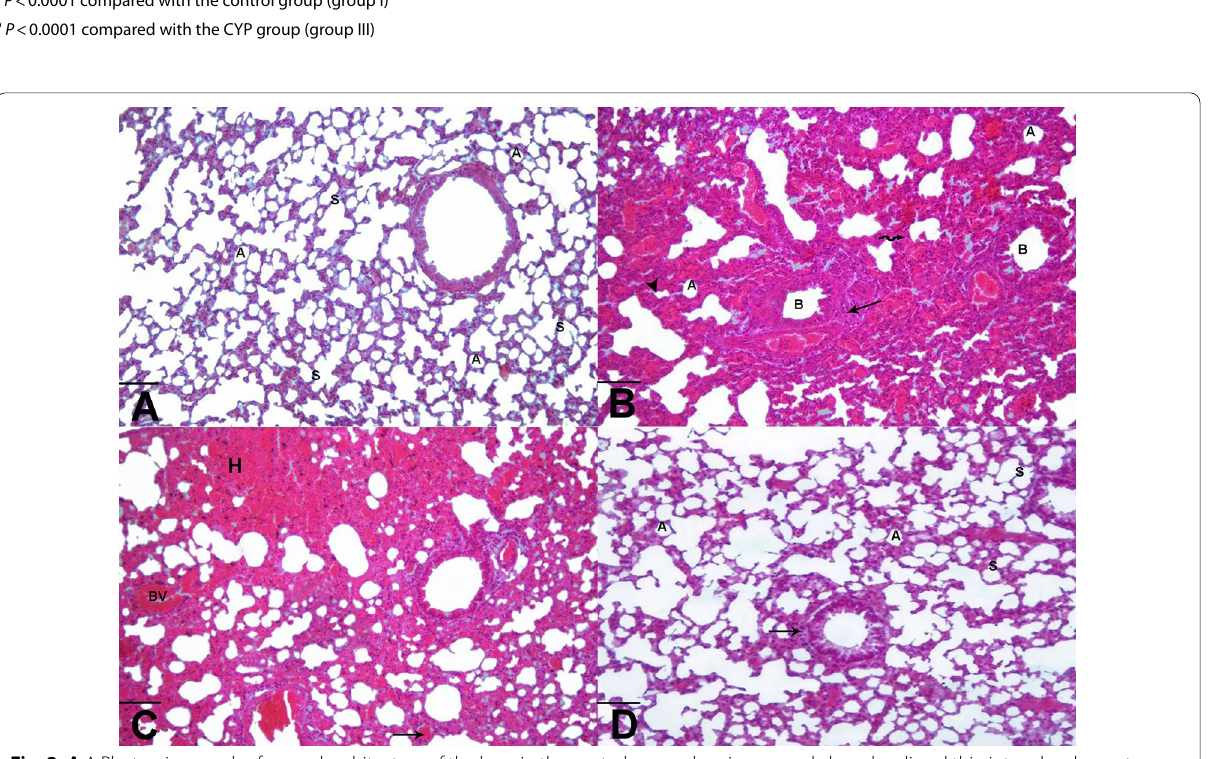
Fig. 2 A A Photomicrograph of normal architecture of the lung in the control group showing normal clear alveoli and thin inter-alveolar septa (H&E, scale bars 40 µm). B , C Photomicrographs of Lung of CYP-treated rats. B Loss of the normal architecture of the lung with extensive = infiltration by inflammatory cells